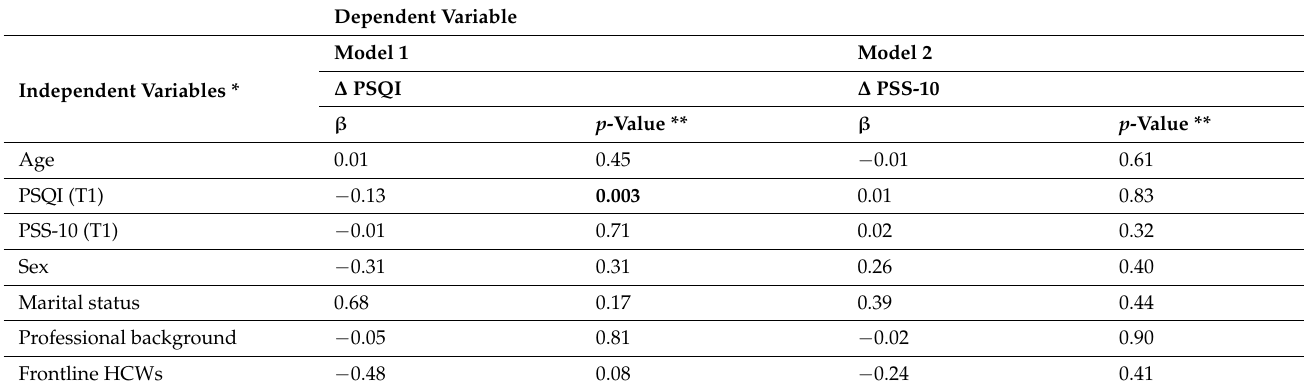
Table 4. Association between selected predictive variables and the change in sleep quality scores and stress scores of the study